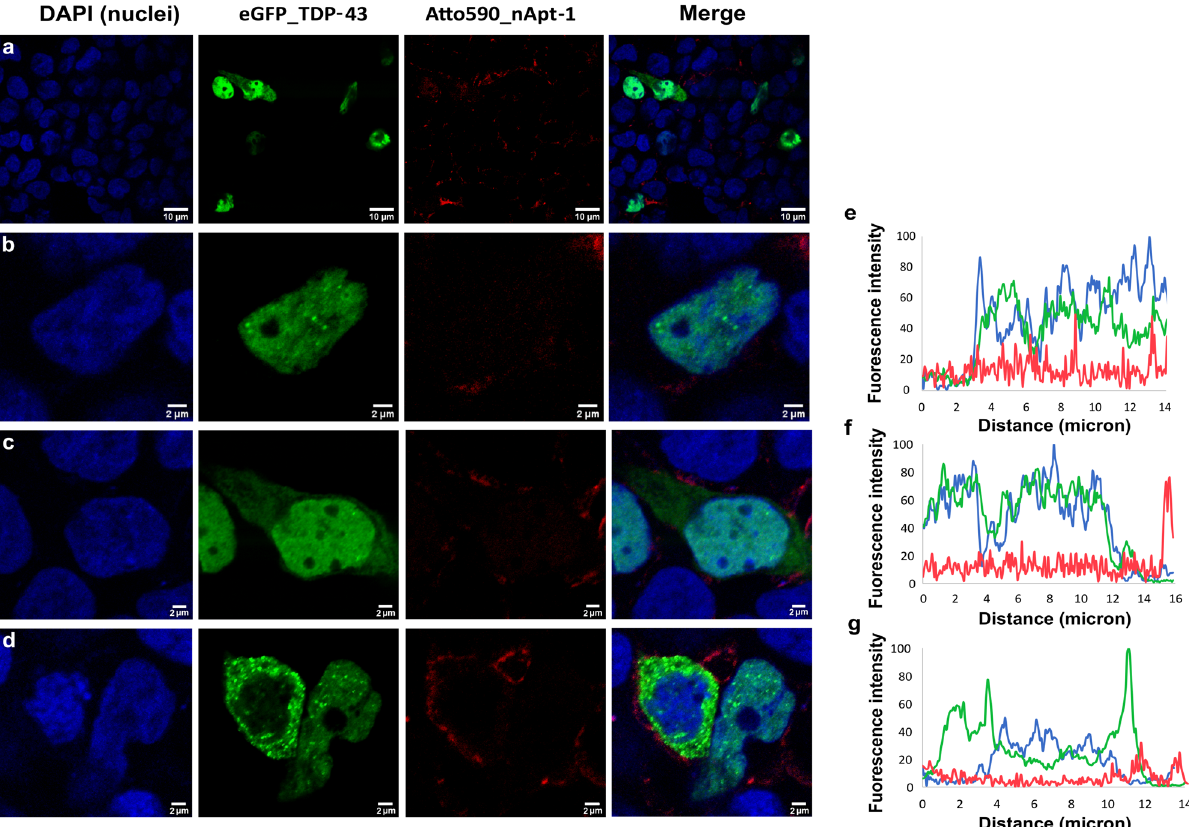
Fig. 7 Confocal microscopy analysis of TDP-43 and nApt-1 in live mammalian cells. Blue: DAPI; green: eGFP_TDP-43; red: nApt-1_Atto590. a Wide view of Hek293T cells co-transfect with the plasmid for the overexpression of full-length TDP-43 fused to eGFP and the aptamer nApt-1 conjugated to the fl uorophore Atto590. b – d Examples of isolated cells co-transfected as in ( a ), in which the lack of correlation between green and red fl uorescence distribution is evident. e – g Fluorescence pro fi les of DAPI, eGFP, and Atto590 along a diagonal line drew across the isolated correspondent cells on the left, showing how nApt-1_Atto590 mostly localized in the peri-cytoplasmatic regions, irrespective of the distribution of